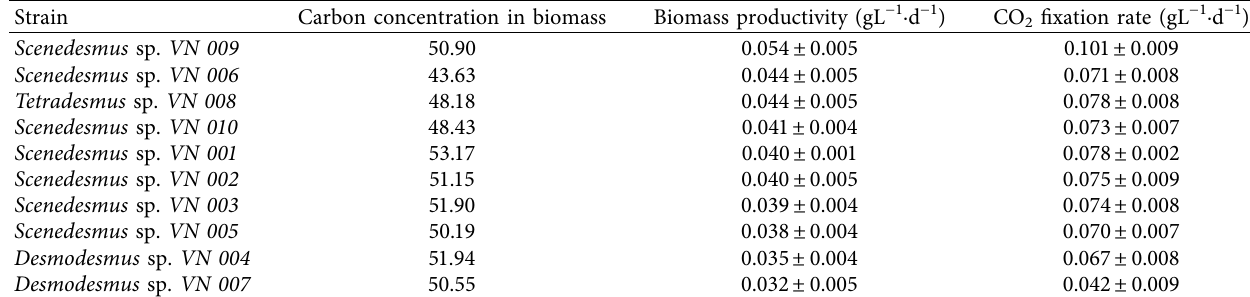
Table 5: CO 2 fixation rate was observed in each studied microalgal strain.